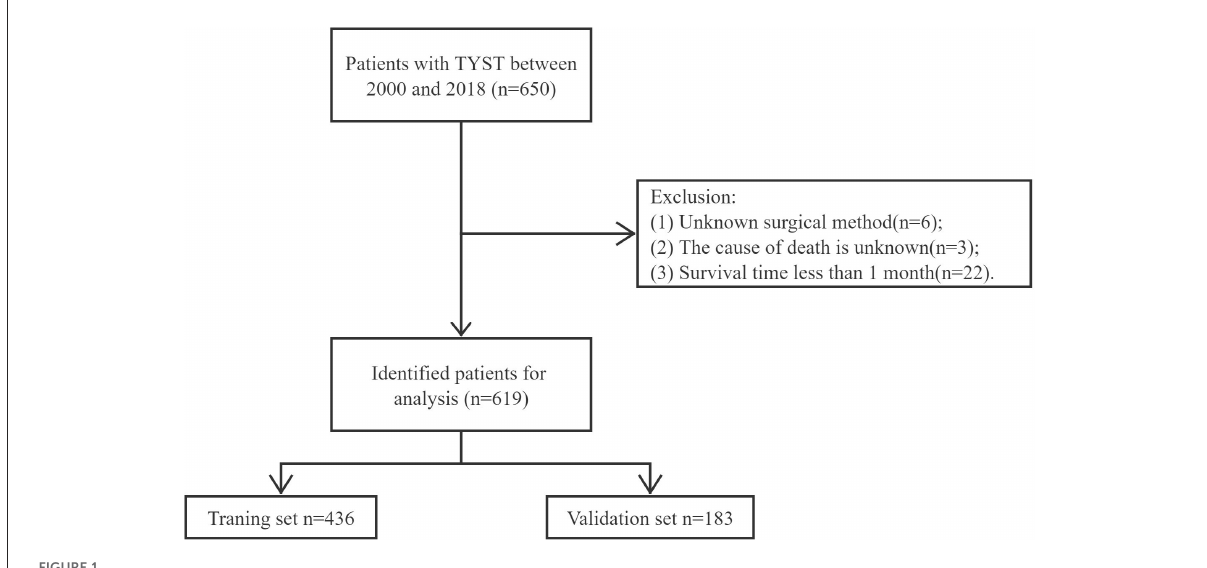
FIGURE1 Flowchart for inclusion and exclusion of all patients with TYST.